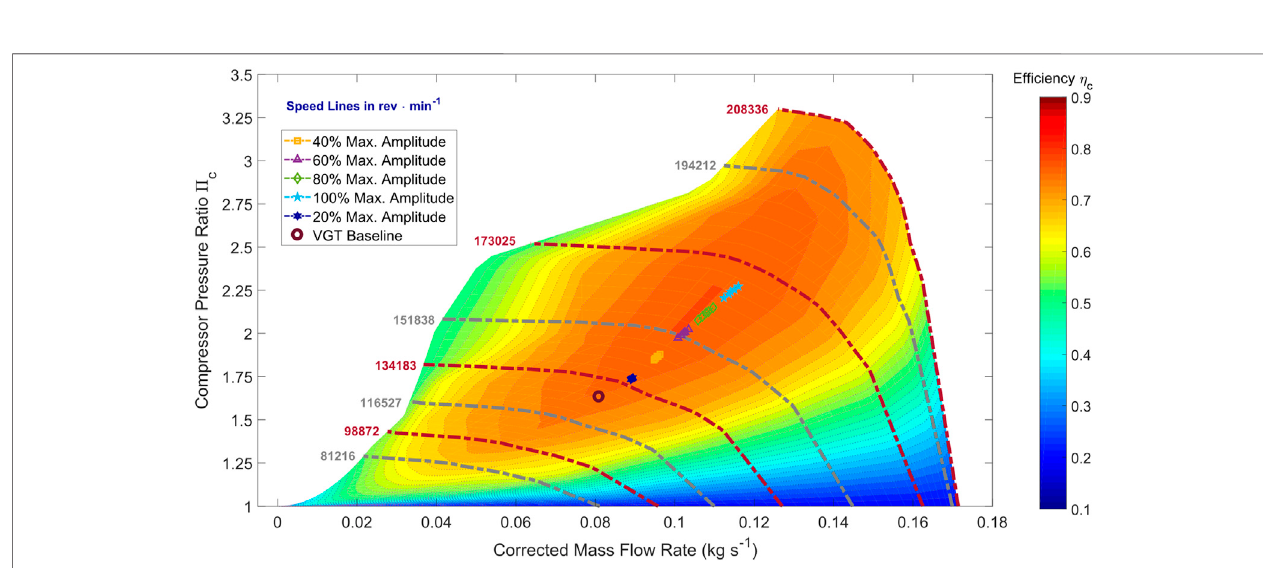
FIGURE12| C101compressormapshowingtheoperatingpointsforbaselineVGToperationandACToperation.NotethatwithACT,thecompressoref fi ciencies are higher, and the operating points move closer to the heart of the map.